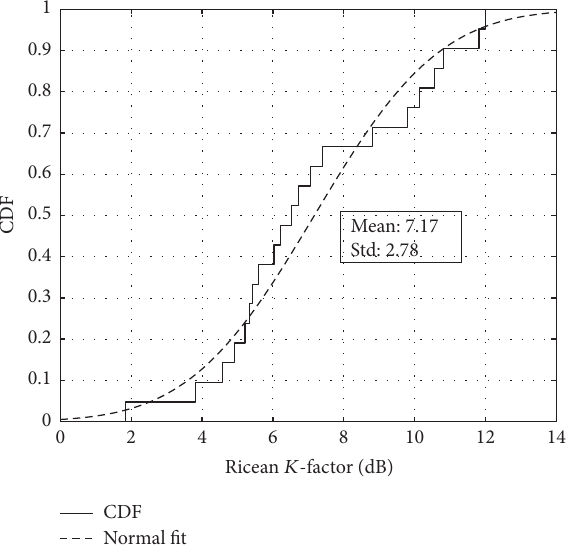
Mean: 7.17 Std: 2.78